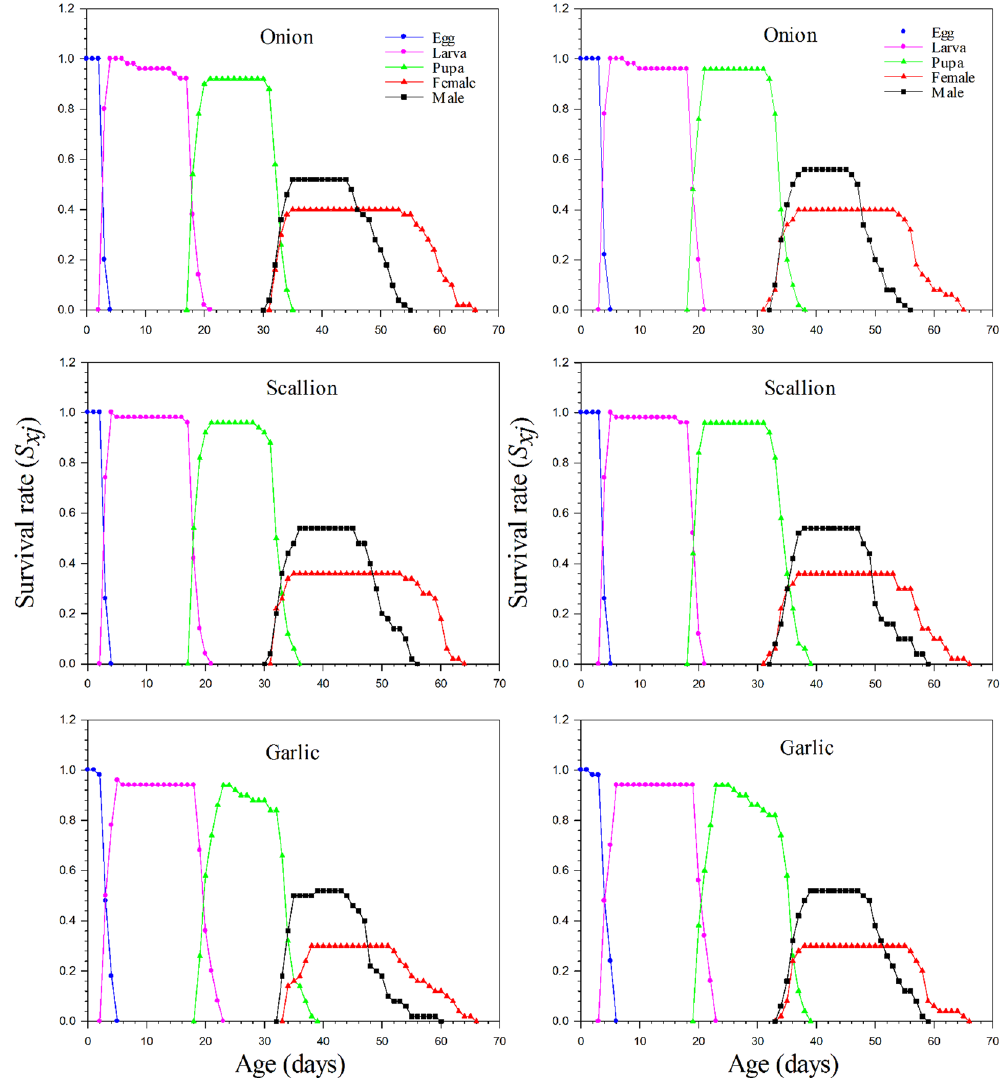
Figure 1. Survival rate to different development stages of Delia antiqua on different host plants. Left: Individually reared method; Right: Group reared